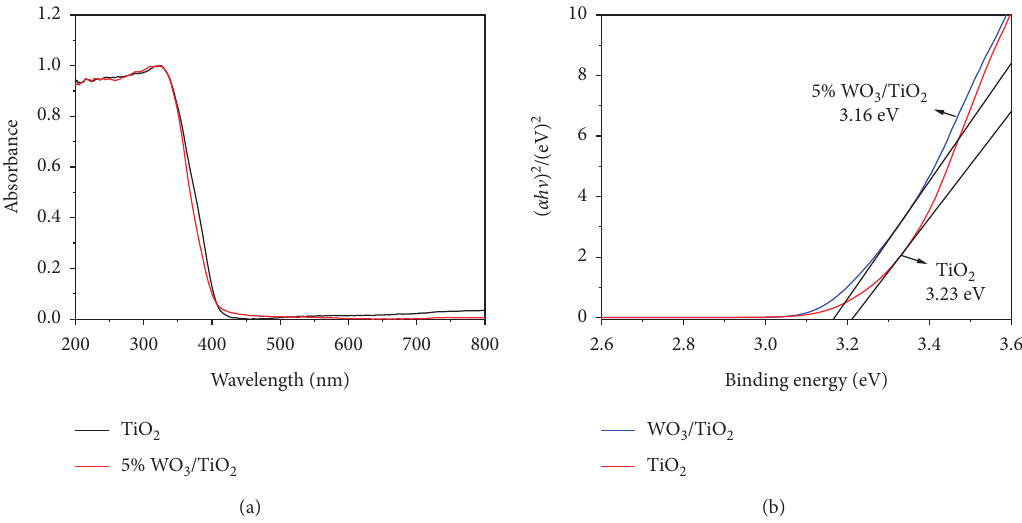
Figure 8: UV-Vis DRS spectra of TiO